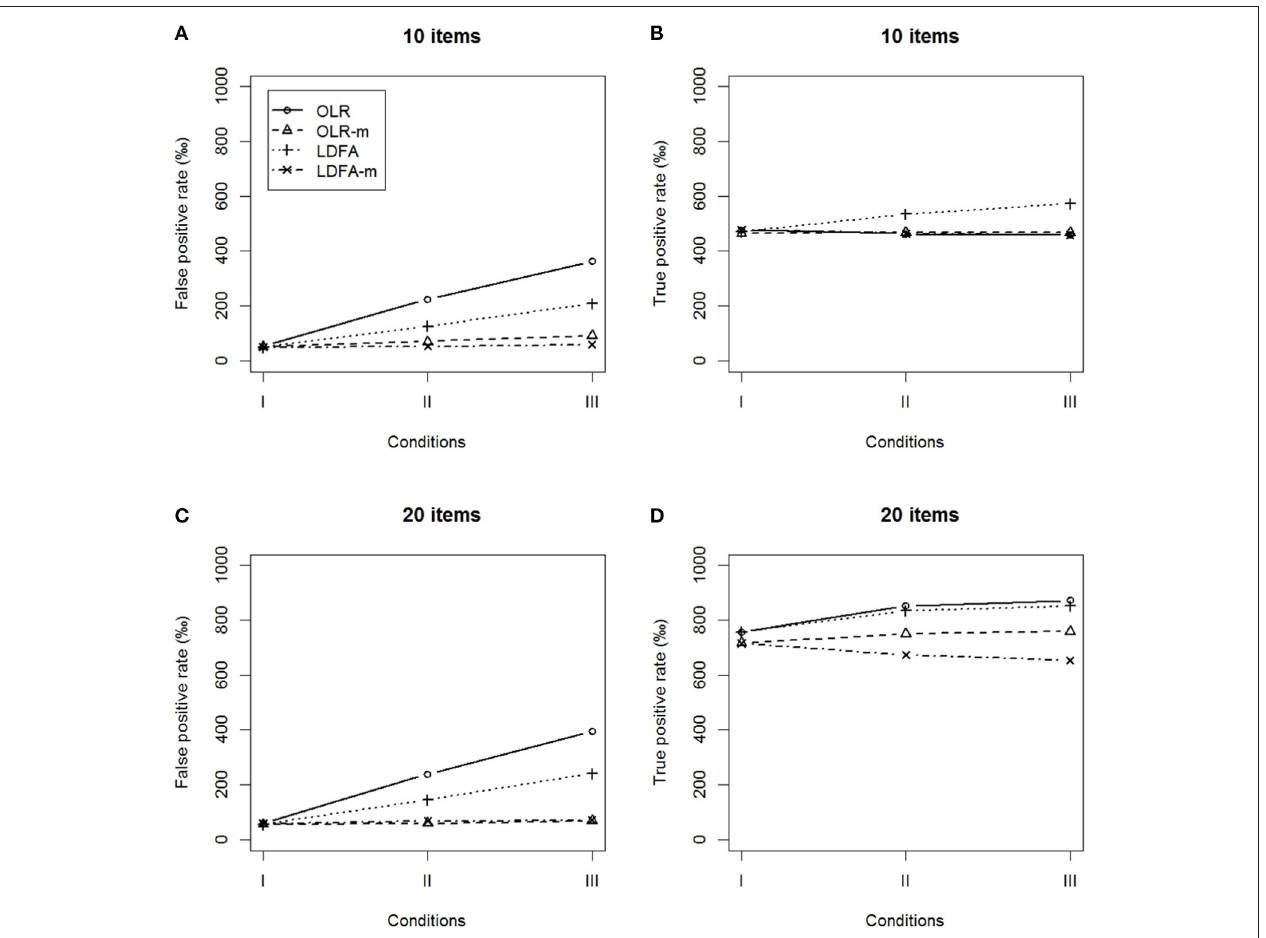
FIGURE 4 | False positive rates and true positive rates under the conditions of balanced DIF. (A,B) 10 items and (C,D) 20